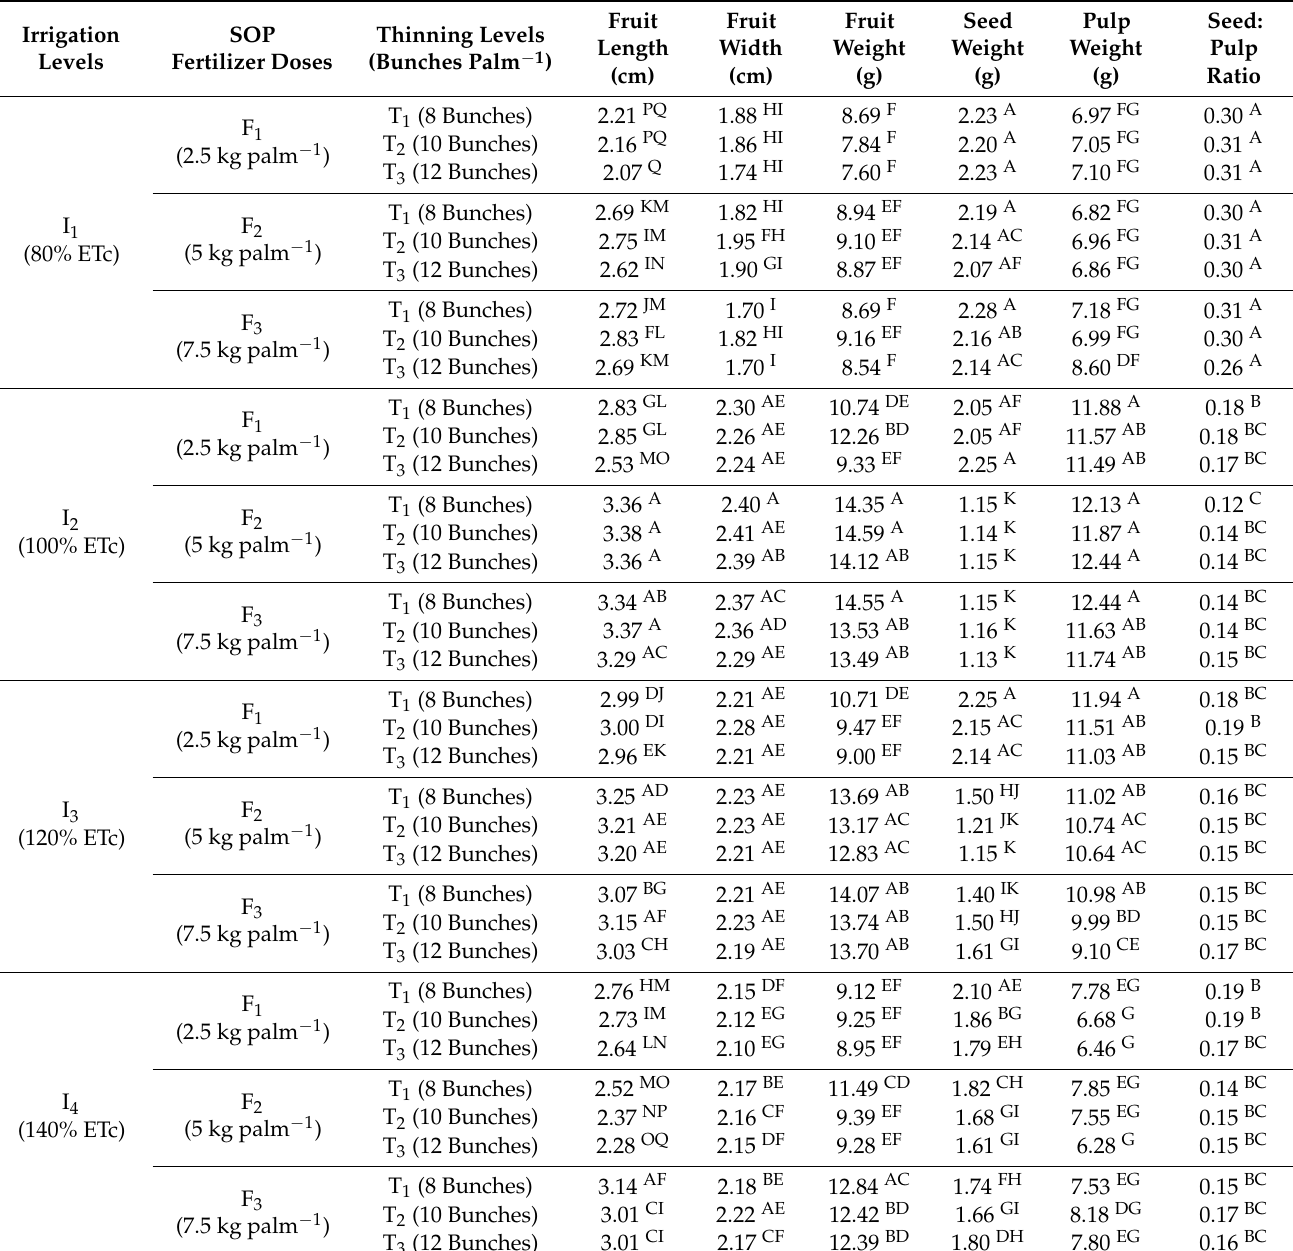
Table 2. Effects of irrigation levels, SOP fertilizer doses, and bunch thinning levels on the fruit length, fruit width, fruit weight, seed weight, pulp weight, and seed pulp ratio of date palm cv. Sukary. Each mean data represents the averages from two seasons,